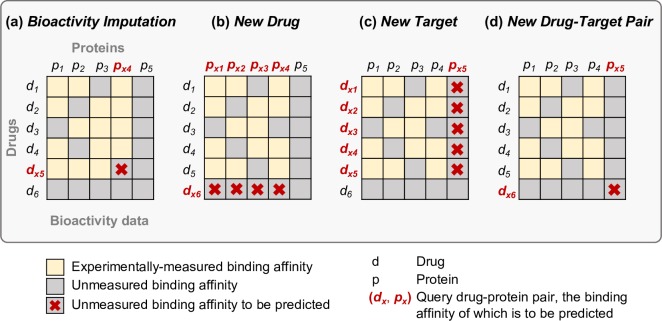
Drug-protein interaction prediction scenarios.(dx, px) denotes a query drug-protein pair, the binding affinity of which is to be predicted. (a) The Bioactivity Imputation scenario: both the drug dx and protein px are present in the training set, i.e., there exist known bioactivity values for the drug dx and protein px, but not for their interaction (dx, px). (b) The New Drug scenario: the protein px is present in the training set, whereas the drug dx is not, i.e., there exist known bioactivity values for the protein px but not for the drug dx. (c) The New Target scenario: the drug dx is present in the training set, whereas the protein px is not, i.e., there exist known bioactivity values for the drug dx, but not for the protein px. (d) The New Drug-Target Pair scenario: neither the drug dx nor protein px is present in the training set, i.e., there exist no bioactivity values neither for the drug dx nor protein px. In this work, we focused primarily on two most common and practical prediction scenarios of (a) and (b), which correspond to filling the gaps in existing experimentally-measured drug-target interaction maps and prediction of target interactions for an investigational drug compound, respectively.